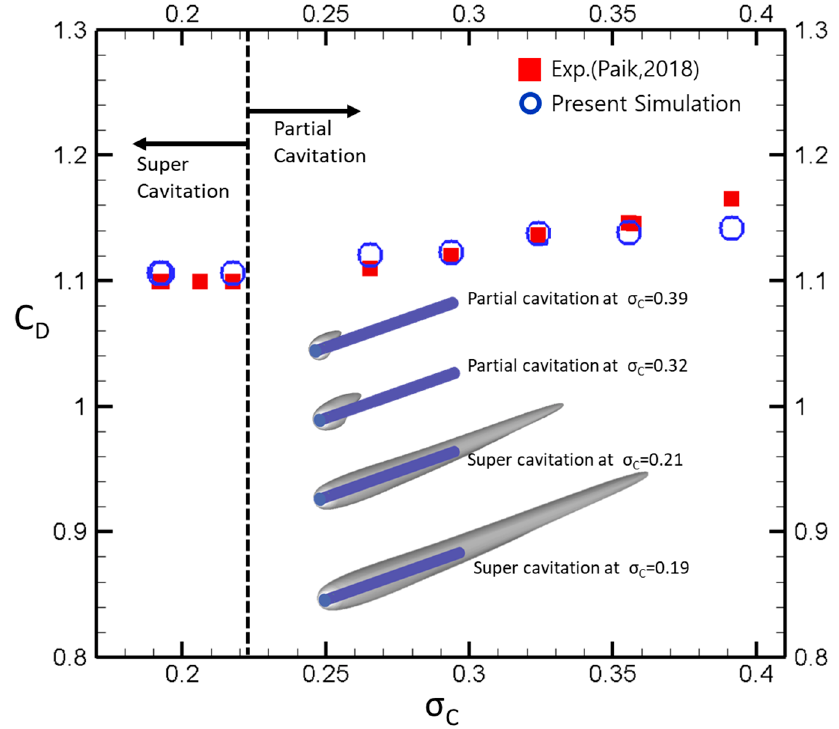
Figure 10. Comparison of drag coefficient according to the various ventilated supercavitations.